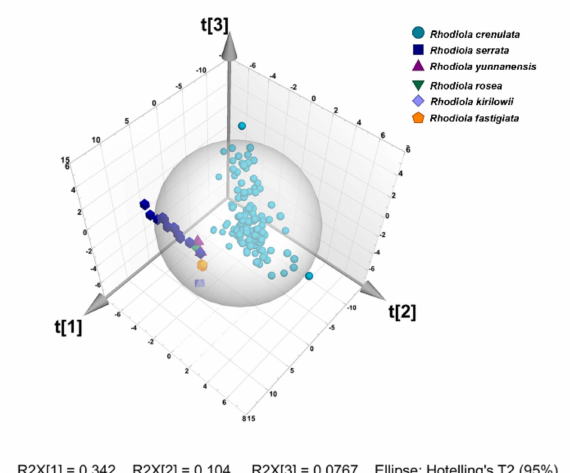
Figure 2. Score plot of PCA on the first three principal components for Rhodiola